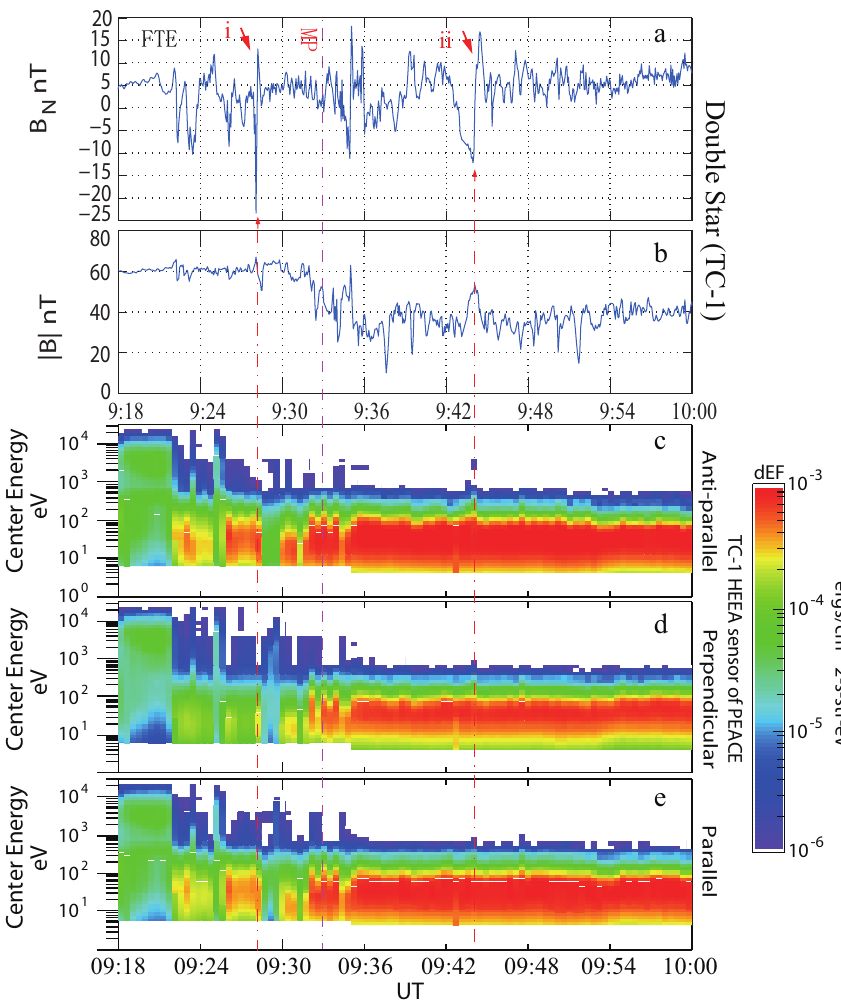
Fig. 5. Zoom in of the magnetic field boundary normal component B N (same as Fig. 3c) and the field magnitude, together with PEACE electron spectrograms in anti-parallel, perpendicular, and parallel directions, observed by TC-1.